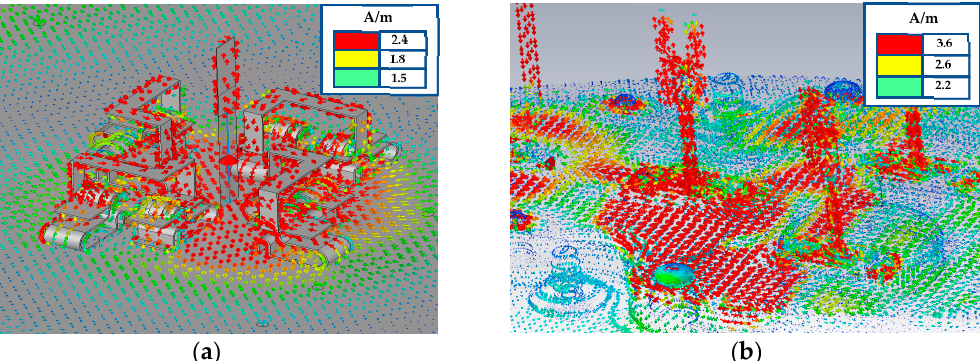
Figure 8. Surface current when installed on the shark-fin module: ( a ) Monopole with quadruple closed-loop devices, and ( b ) monopole-only wave antenna.